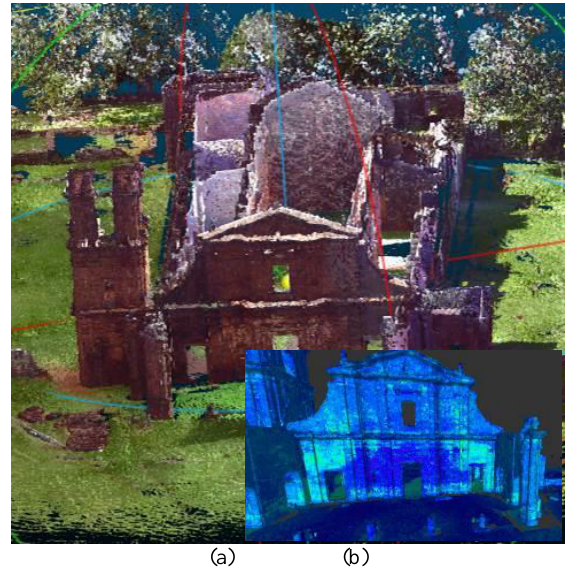
Figure 7 – (a) Point cloud registered and georeferenced acquired with Faro Focus 3D HD; (b) Images of gray intensity Figure 5 – TLS systems: (a) Optech ILRIS 3D HD; (b) Faro showing the humidity of the walls of the Church Focus 3D S